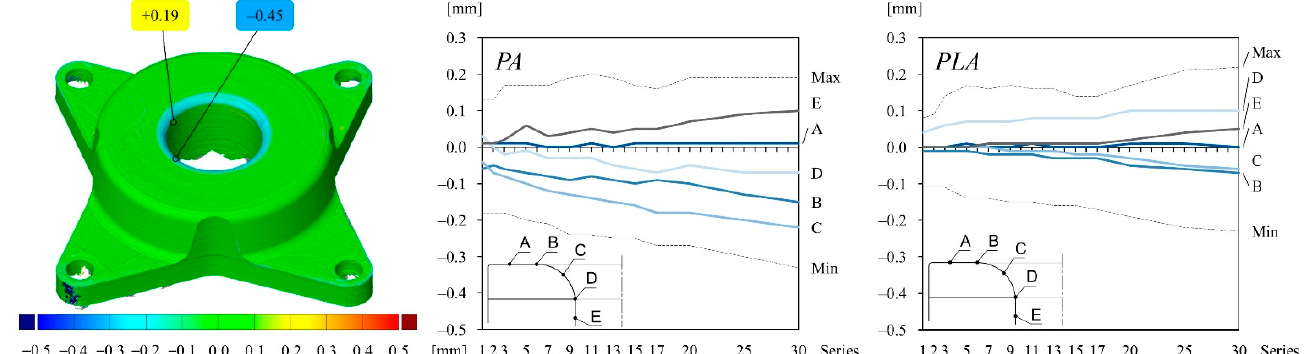
Figure 9. Deviation values (wear) of different measuring points on the die surface compared to the initial die geometry of both material configurations: ( left ) selected measuring points; ( middle ) deviation values of PA die over the course of 30 drawing operations; ( right ) deviation values of PLA die over the course of 30 drawing operations. The drawing inside the diagram indicates the location of the measuring points on the die surface.